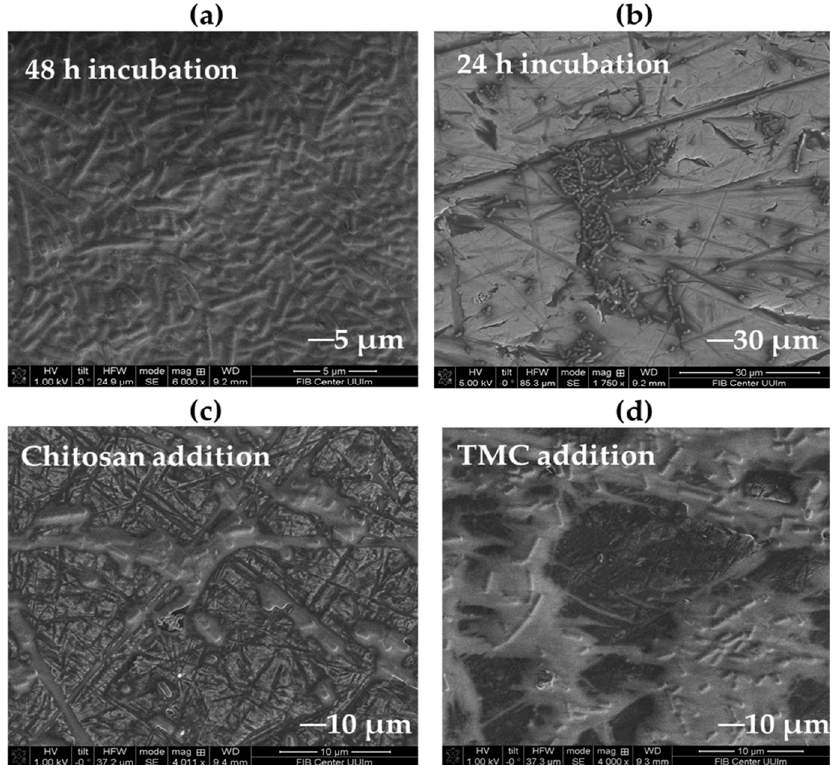
Figure 9. SEM micrographs of L. parabuchneri biofilm inhibition by chitosan and TMC; ( a ) after 48 h of incubation, ( b ) after 24 h of incubation, ( c ) after chitosan addition and ( d ) after TMC addition